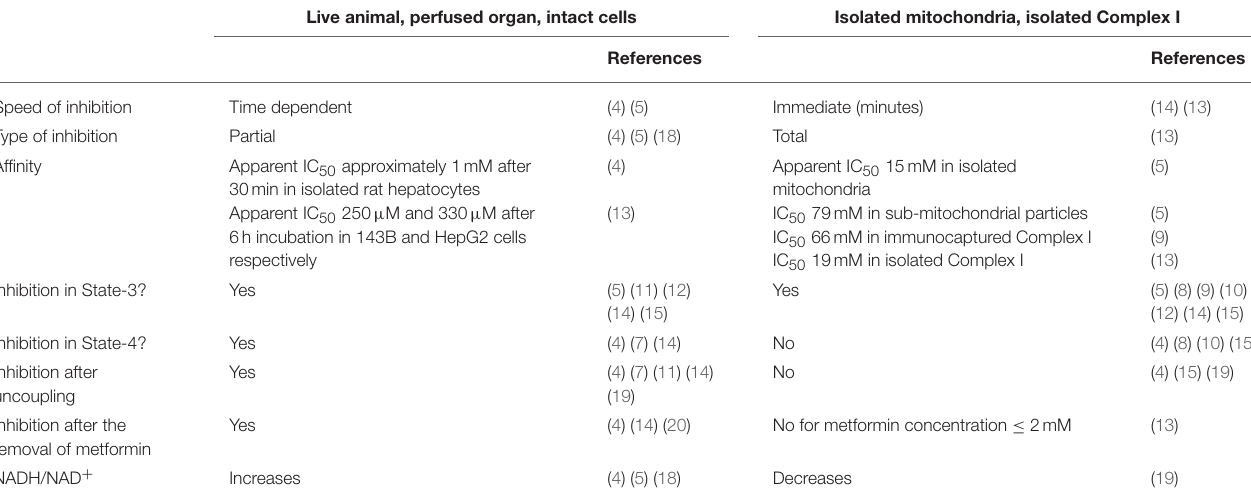
TABLE 1 | Main differences in the characteristics of Complex I inhibition according to the model used. Live animal, perfused organ, intact cells Isolated mitochondria, isolated Complex